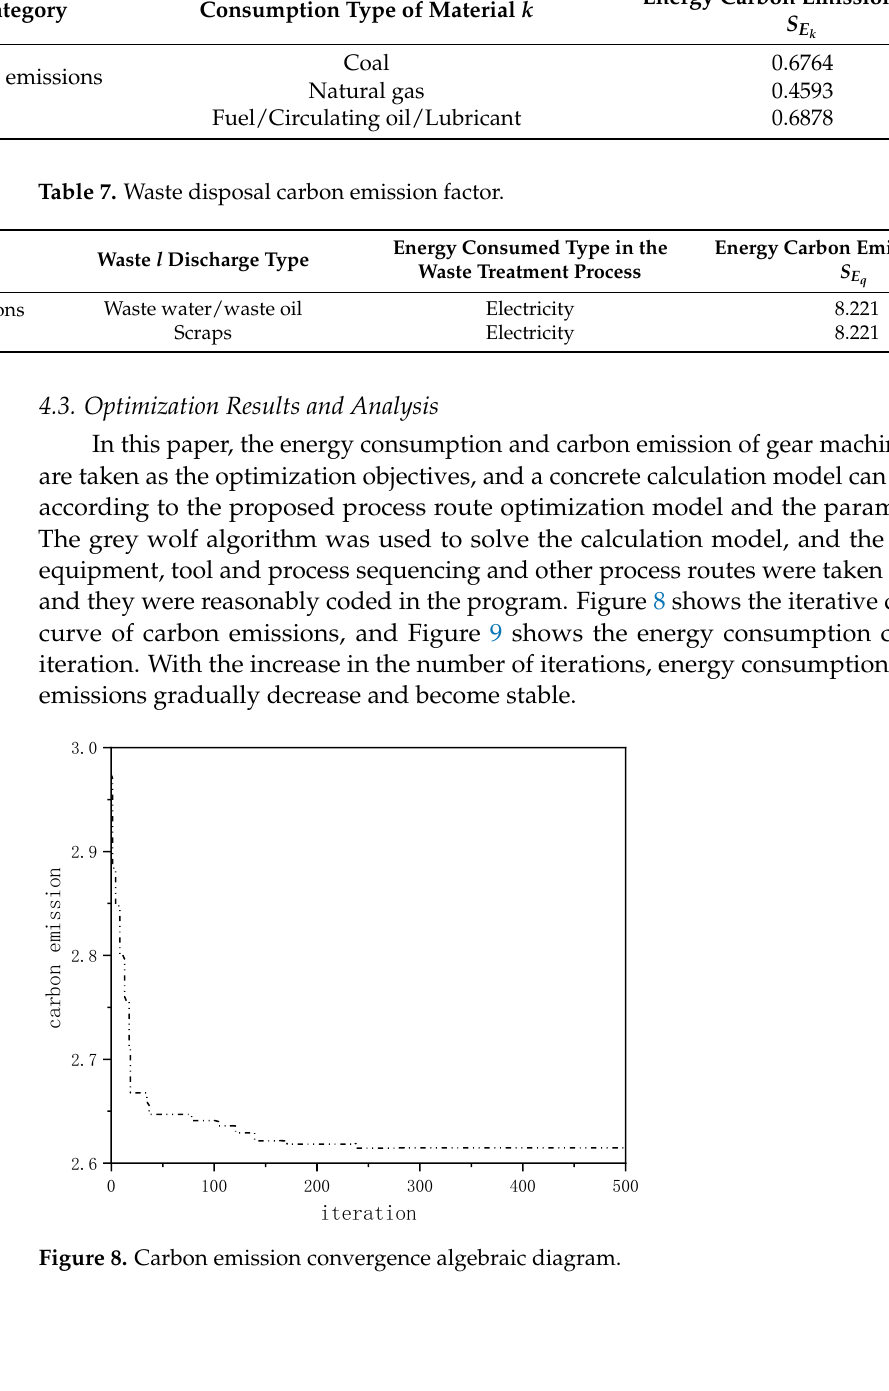
Figure 9. Energy consumption convergence algebraic diagram. 5. Discussion 5.1. Results Analysis The comparison data between the results and the optimization results of low carbon and low energy consumption alone are shown in Table 8. Table 8. Optimization results. Optimization Results